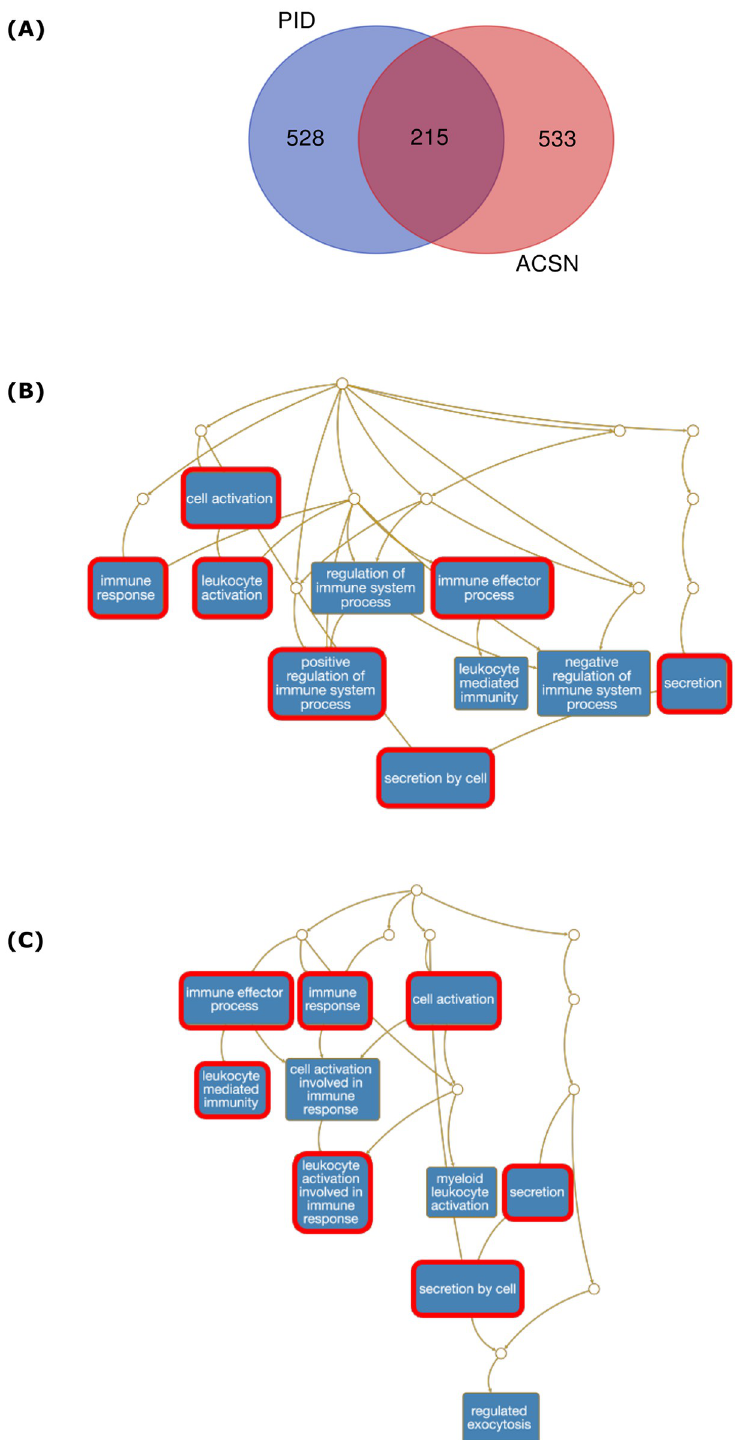
Fig 4. Comparative analysis of Hugo identifiers associated with gene entities of the PID and ACSN cadbiom models. (A) Venn diagram describing the intersection between the HUGO identifiers appearing in gene entities of the PID and ACSN cadbiom models. (B) Over-representation analysis of HUGO identifiers from PID. (C) Over- representation analysis of HUGO identifiers from ACSN. Red boxes are common GO terms between PID and ACSN